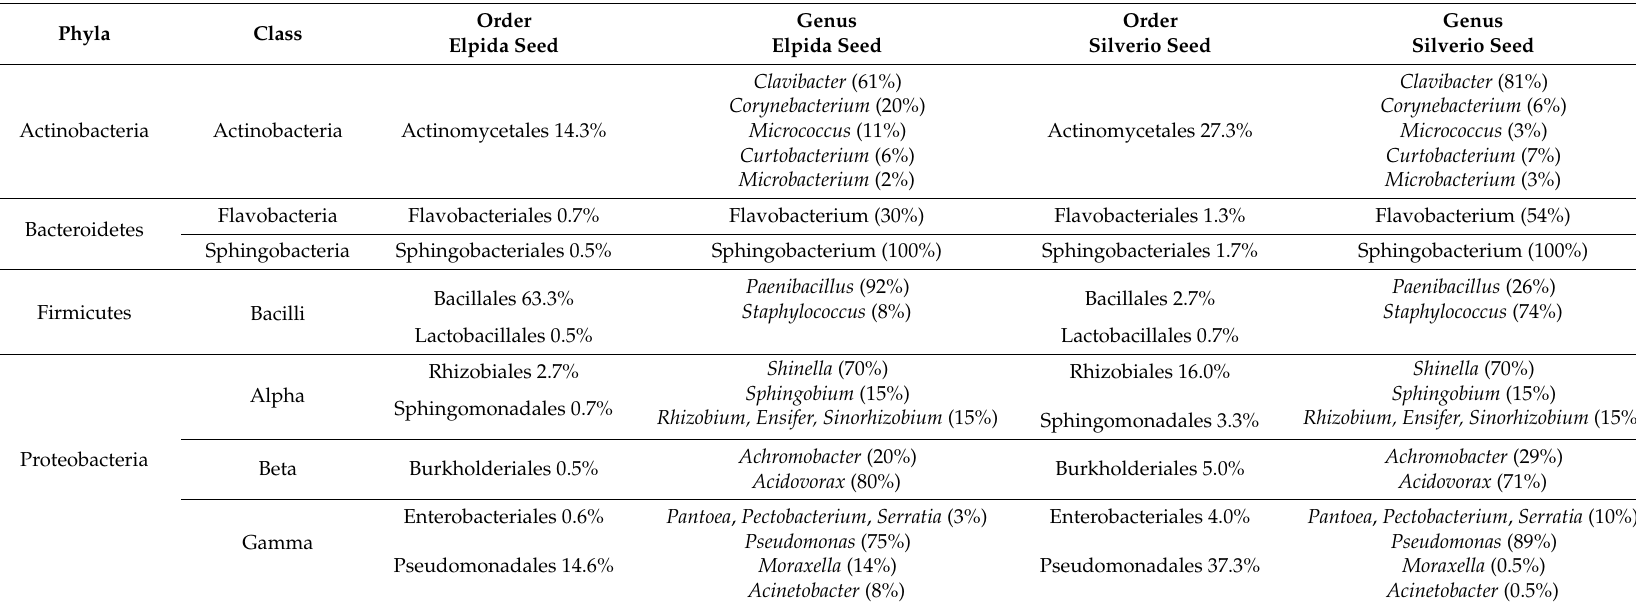
Table 2. The composition of the endophytic communities of Elpida and Silverio seed and seedling at the order and genus levels from the Illumina data